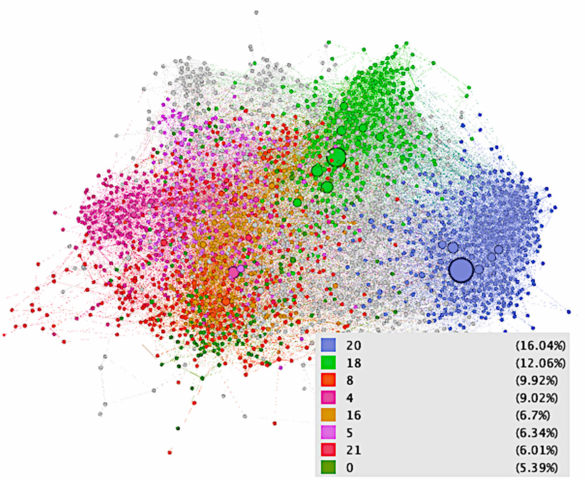
Figure 3. Visualization of the ACL ARC citation network. The citation network illustrates a color- based community structure, nodes having the same colors belong to the same